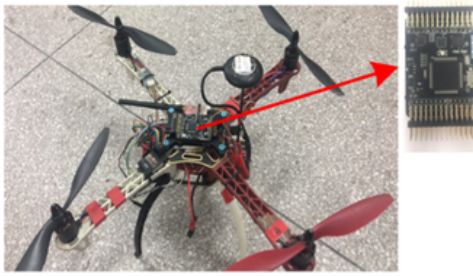
Figure 4. Attitude real-time flight self-designed autopilot